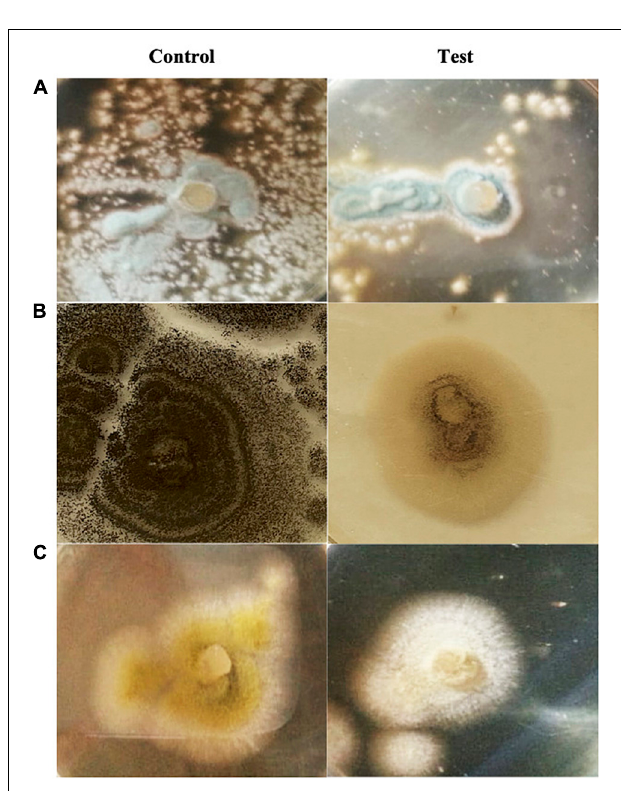
FIGURE 4 | Growth inhibition and antifungal effect of H. werneckii AS1 melanin at a concentration of 100 µ g/ml on (A) Penicillium sp., (B) Aspergillus niger , and (C) Aspergillus oryzae